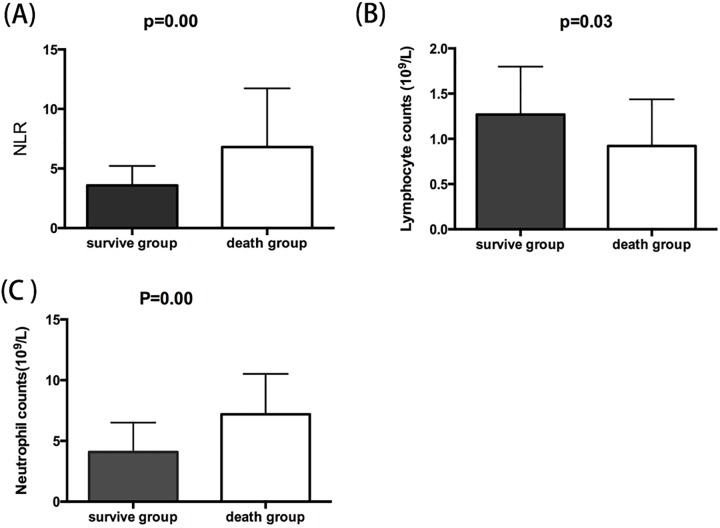
Baseline median NLR (A), LC (B), and NC (C) in the SOC group survivors (solid bars) and in patients who died (open bars). Error bars are IQRs.